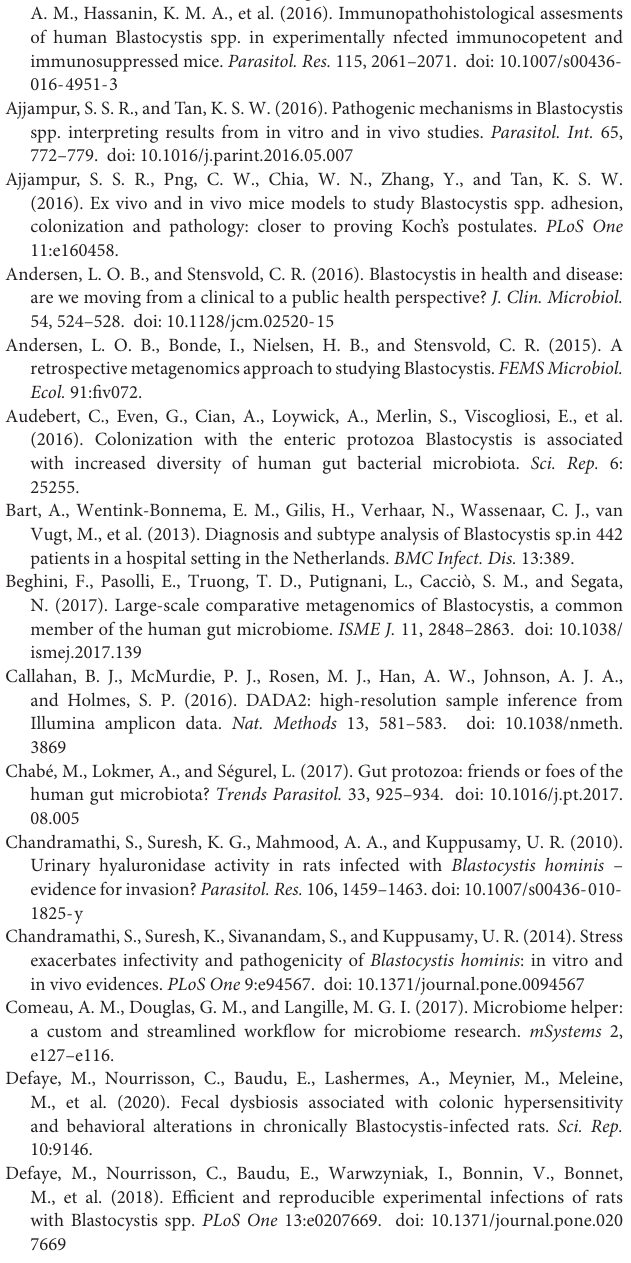
Supplementary Figure 4 | LEFSe cladograms depicting differentially abundant bacterial taxa associated with Blastocystis ST3 colonization in the long-term pilot study B. Day 1 is before Blastocystis ST3 colonization. Days 15, 36, and 50 are after colonization and before colitis induction. There is insufficient sample size for LEFSe analysis after colitis induction (Day 99) and it is not shown. All other notes are the same as Supplementary Figure 1 .